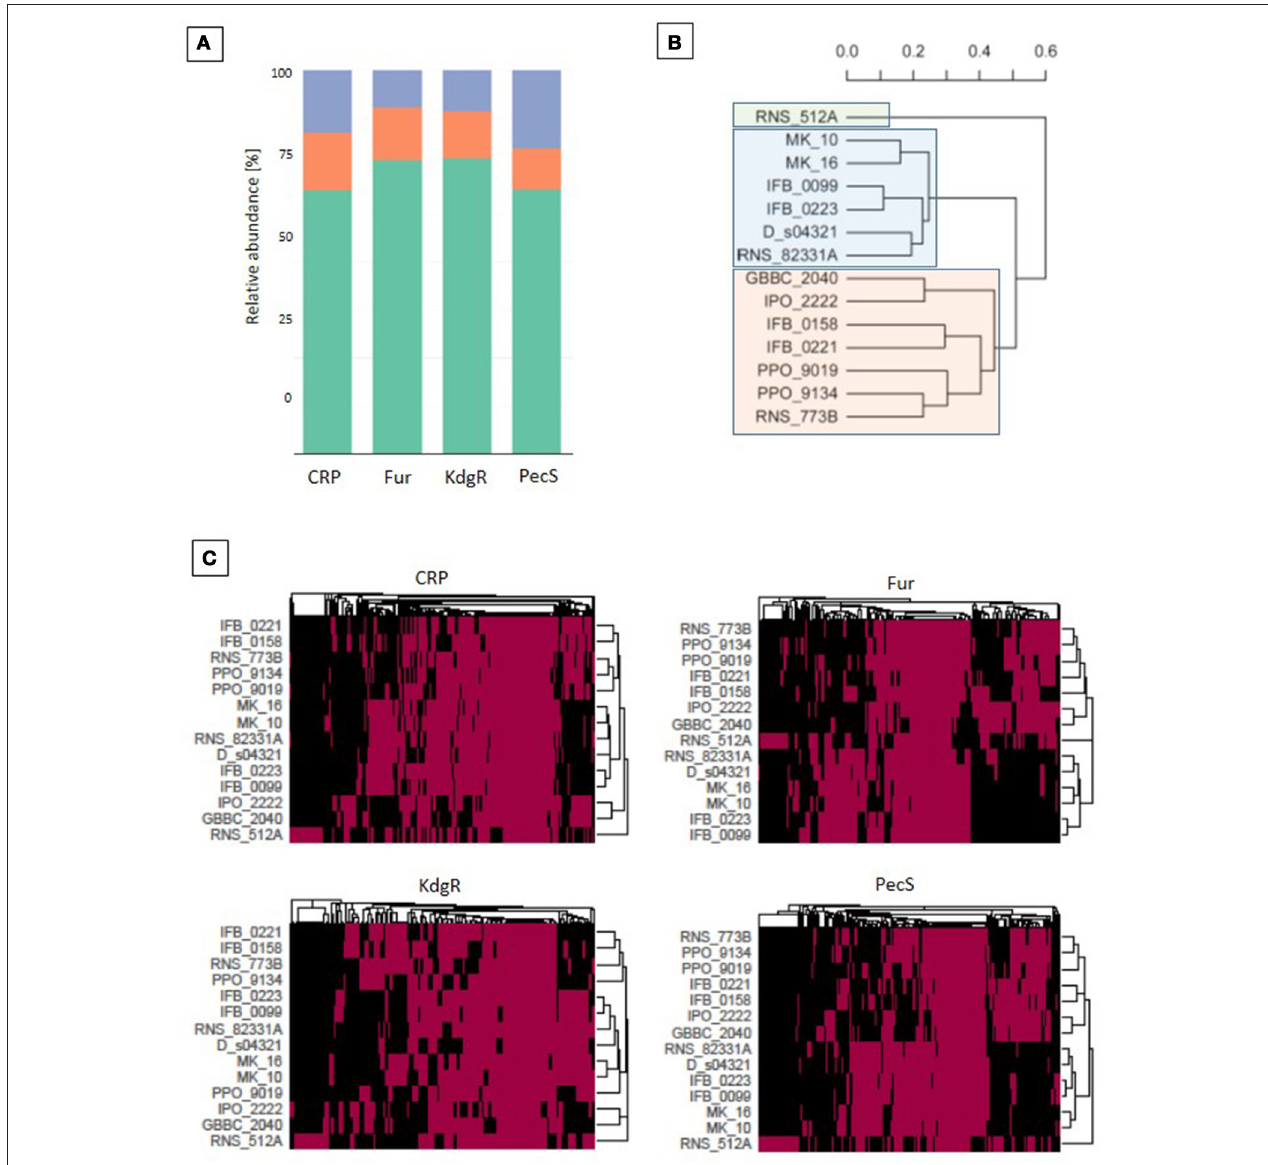
FIGURE 7 | Regulon analysis based on binding sites predictions. Predictions of the transcription regulators (CRP, Fur, KdgR, and PecS) binding sites were made with the use of MAST version 4.10.1. (Bailey and Elkan, 1994) and the version 1.62b of the Bio.motifs package from the Biopython library (Cock et al., 2009). (A) The regulon representation for the 4 transcription regulators (TFs): in orange for core, green for accessory, violet for unique TF targets. (B) Phylogenetic tree based on the total regulons predicted for the 4 TFs. The UPGMA methods on Jaccard distance were utilized for phylogenetic analysis. (C) Heatmaps for CRP, Fur, KdgR and PecS TFs, which represent all predicted genes that are putatively regulated by the selected TF. A red box indicates the presence whereas a black one indicates the absence of a TF binding site in the upstream region of the gene. ( hrpQ ) and a miscRNA called ArcZ, while these genes were present in all other D. solani